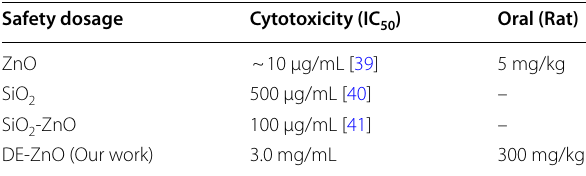
Table 1 Comparison of the cytotoxicity of the DE‑ZnO